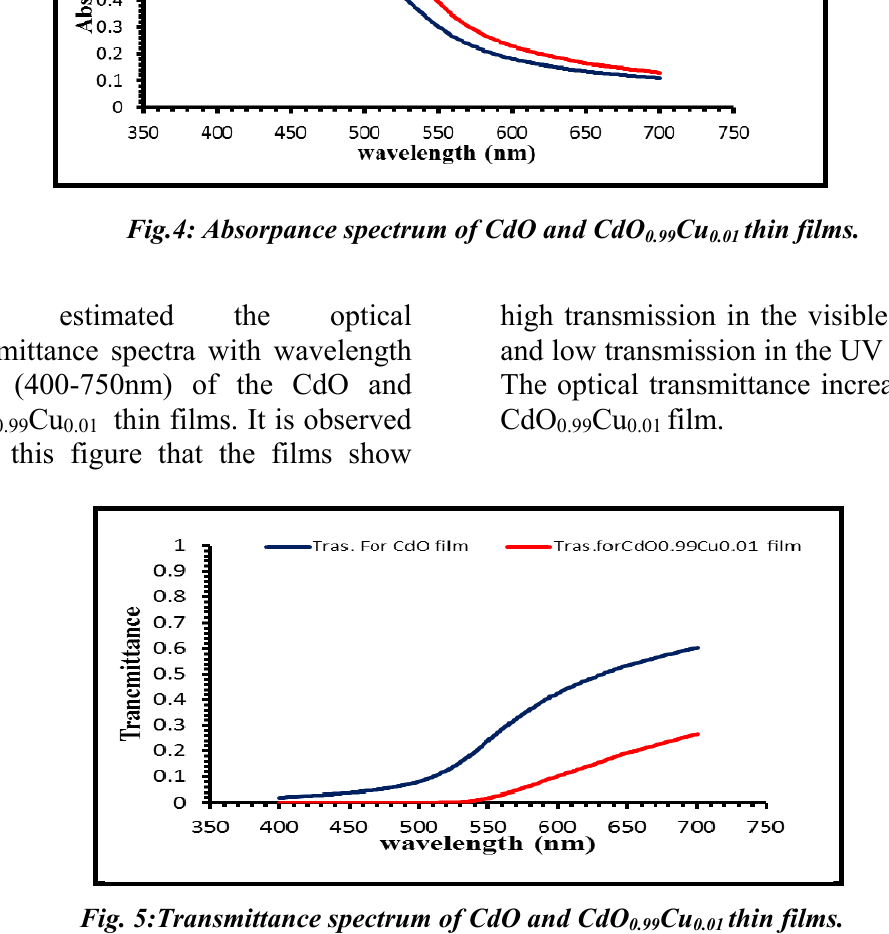
Cu thin films. 0.99 0.01